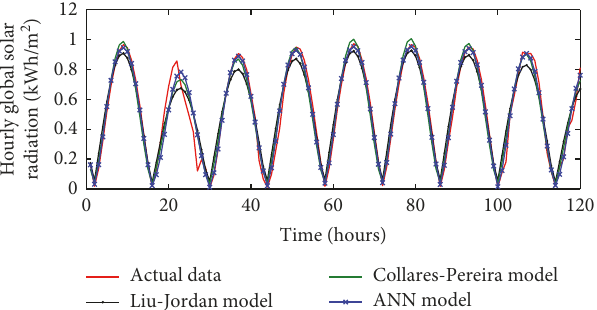
Figure 5: Comparison between ANN results and other procedures of